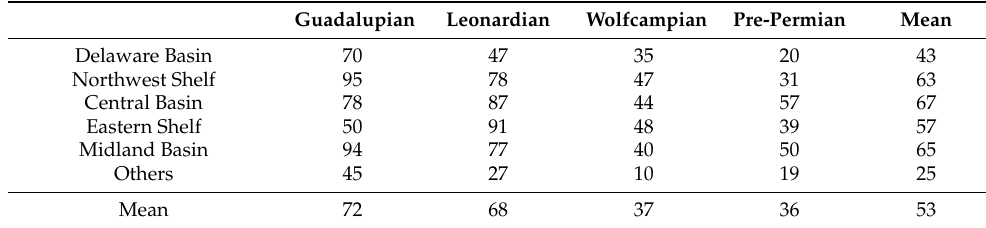
Table 3. Summary of maximum survival times, t surv , in years for the Permian